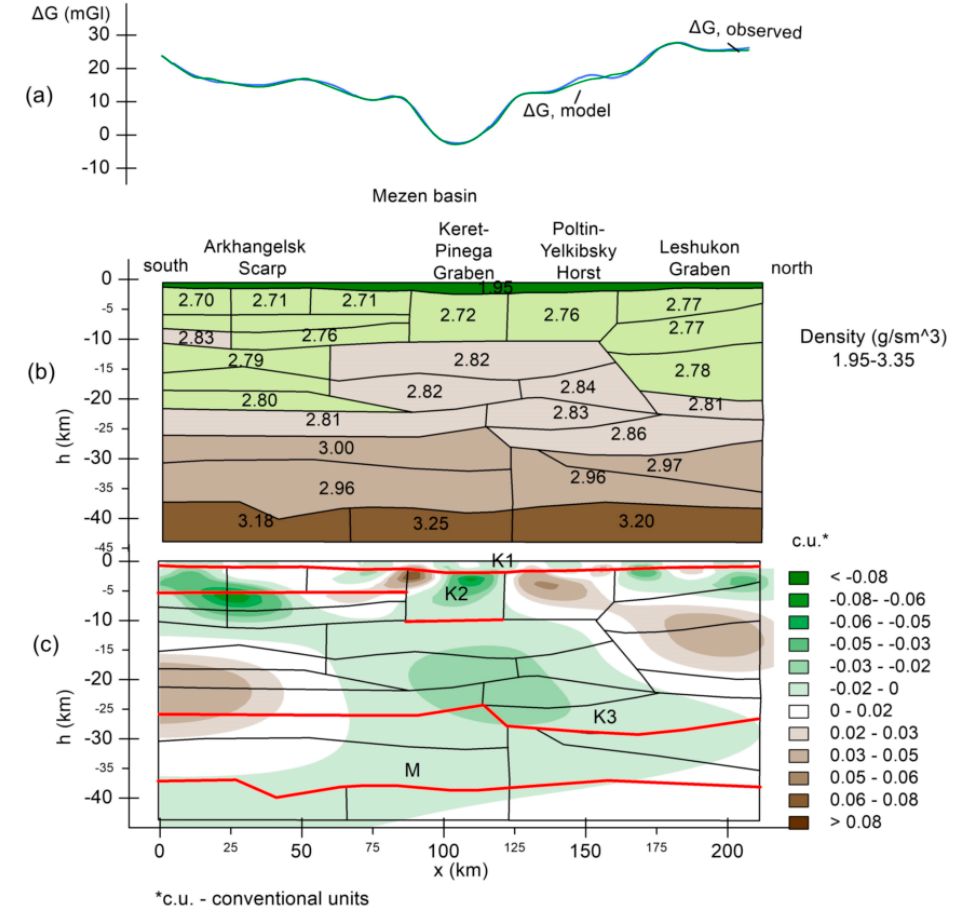
Figure 3. 2D density model for a section of the seismic profile AGATE 3 (Ust Pinega-White Sea): graphs of observed profile Bouger anomaly and model calculated field ( a ), density block model based on seismic data ( b ), and distribution of e ff ective density with boundaries of velocity layers determined from seismic data shown in red ( c ). Conventional units characterize e ff ective density distribution as normalized deviations. The pattern of seals and decompressions in the profile of the earth’s crust ( c ) is given by the results of the Integro procedure of the section 3D density model by 2D profile [20,25]. The boundaries of the layers of the reference velocity model in Figure 3 are highlighted in